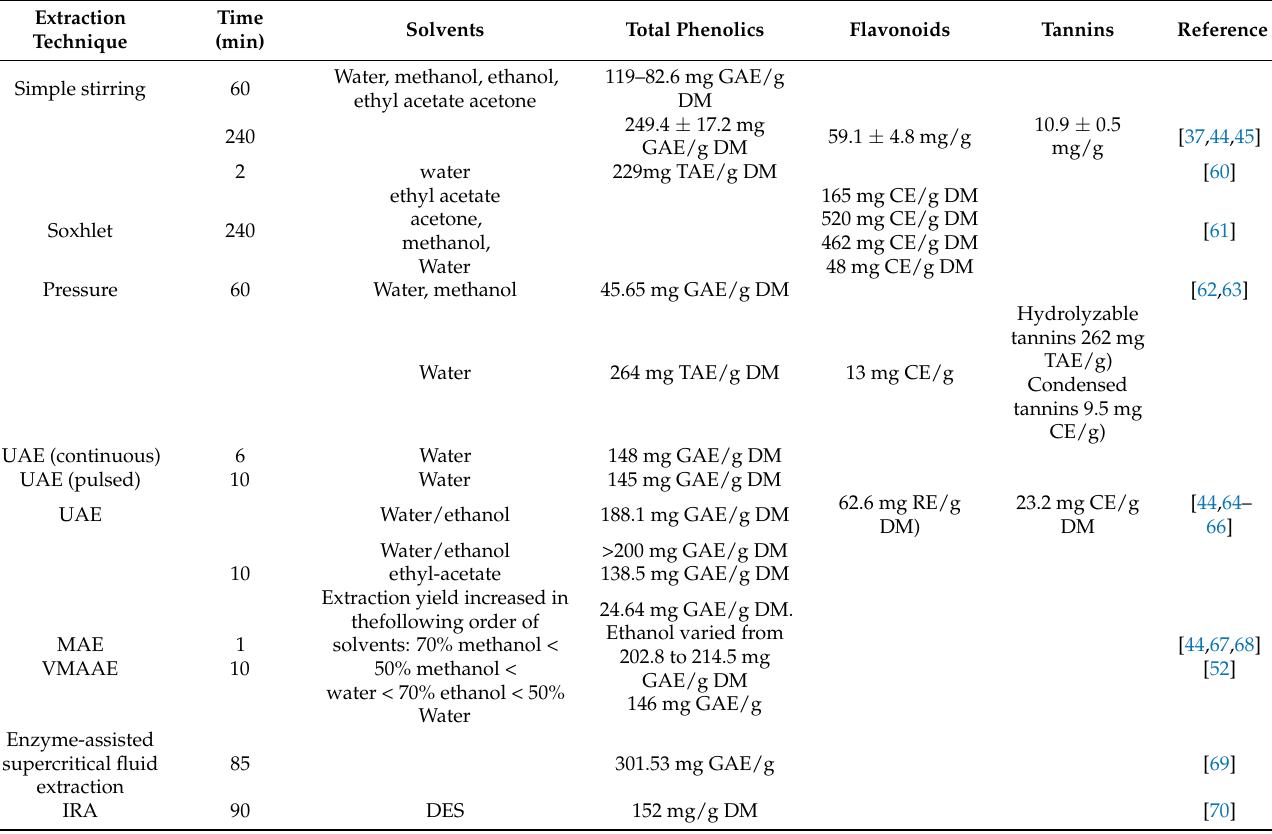
Table 1. Characteristic of various phenolic extraction techniques from